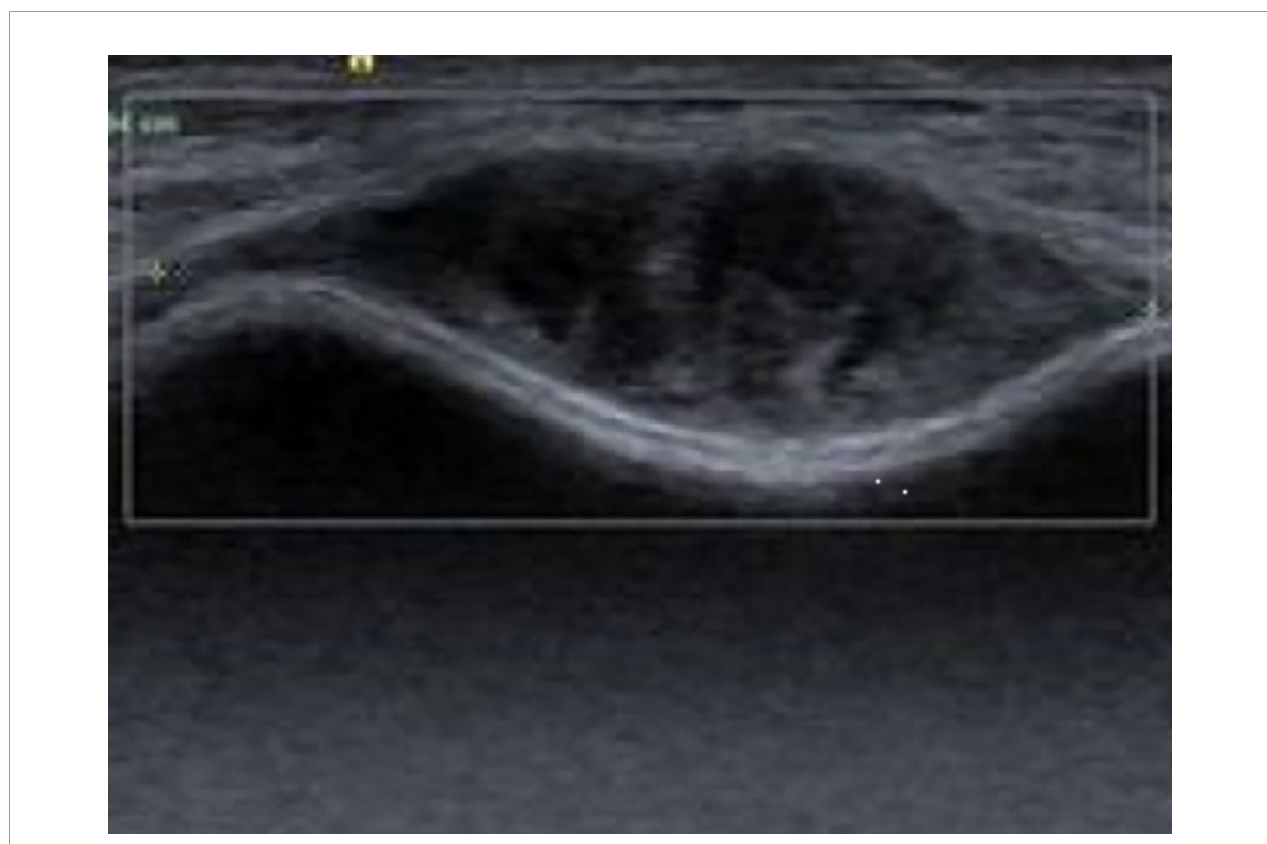
FIGURE 1 | A regular hypoechoic mass on breast